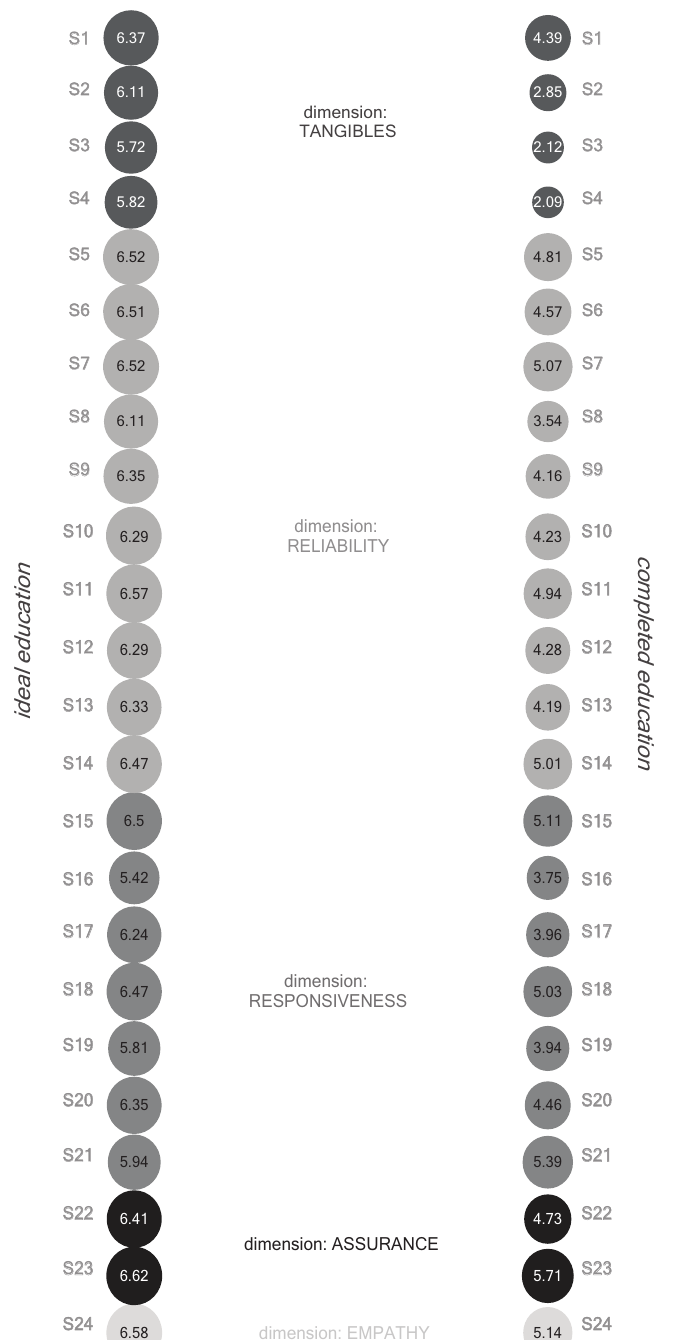
Figure 7. Summary of average grades for individual statements relating to vocational guidance